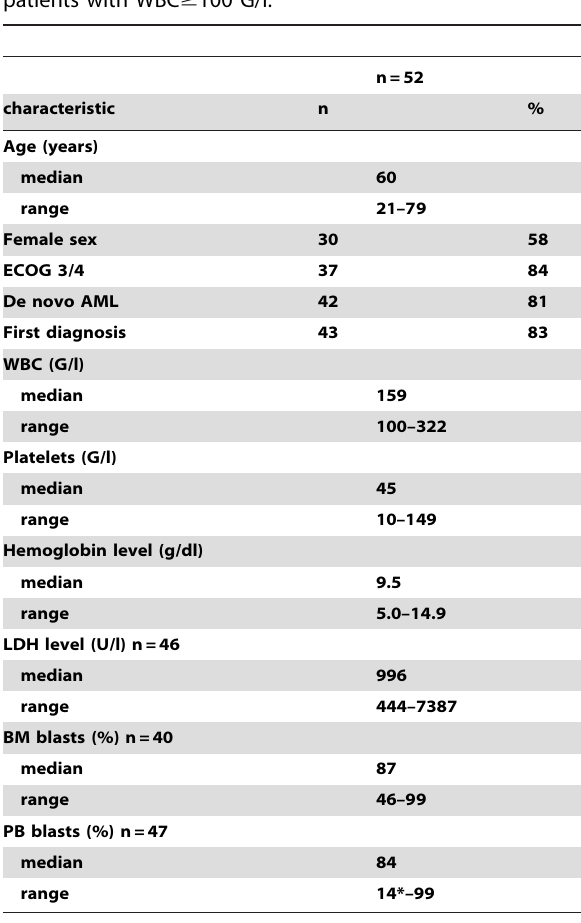
Table 1. Patient characteristics of all intensively treated patients with WBC $ 100 G/l.